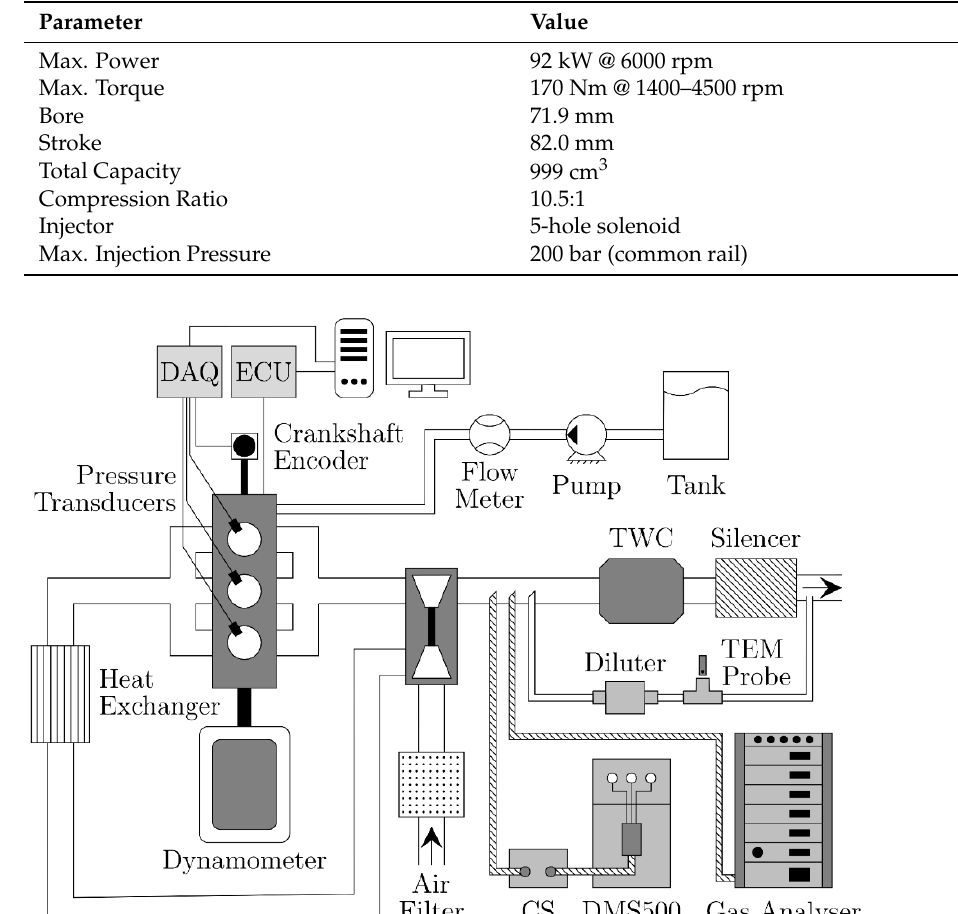
Figure 1. Schematic of the engine test setup with connected measurement instruments.